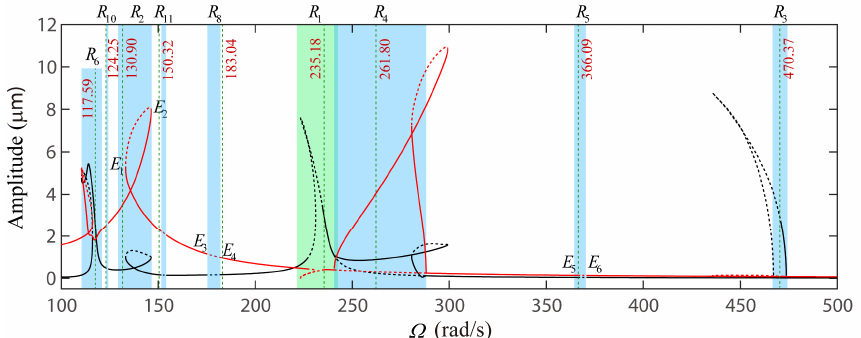
Figure 14. For δ 0 = 4.0 μ m, stable (solid) and unstable (dashed) VC periodic peak-to-peak frequency–response curves in x (red line) and y (black line) directions.